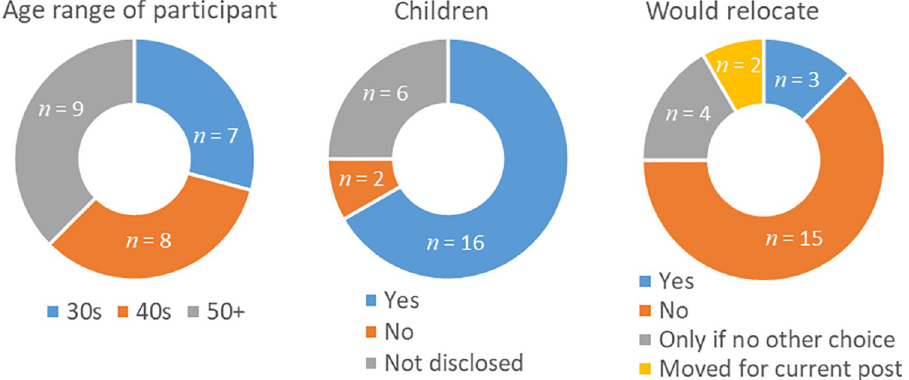
Fig 1. Demographic information about the research participants. Left: Disclosed and estimated age in 10–year age bands. Middle: Number of participants with children or otherwise. Right: Willingness to relocate for a position.